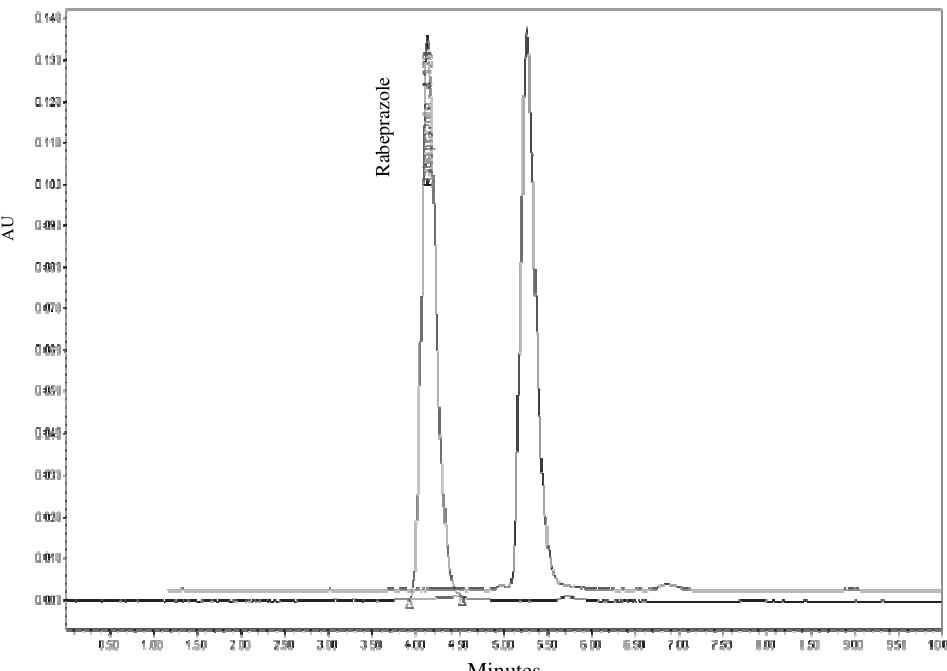
Figure 2. Chromatograms of rabeprazole (left to right) extracted from formulation (40 µg/mL) and standard solution (40 µg/mL) Accuracy and